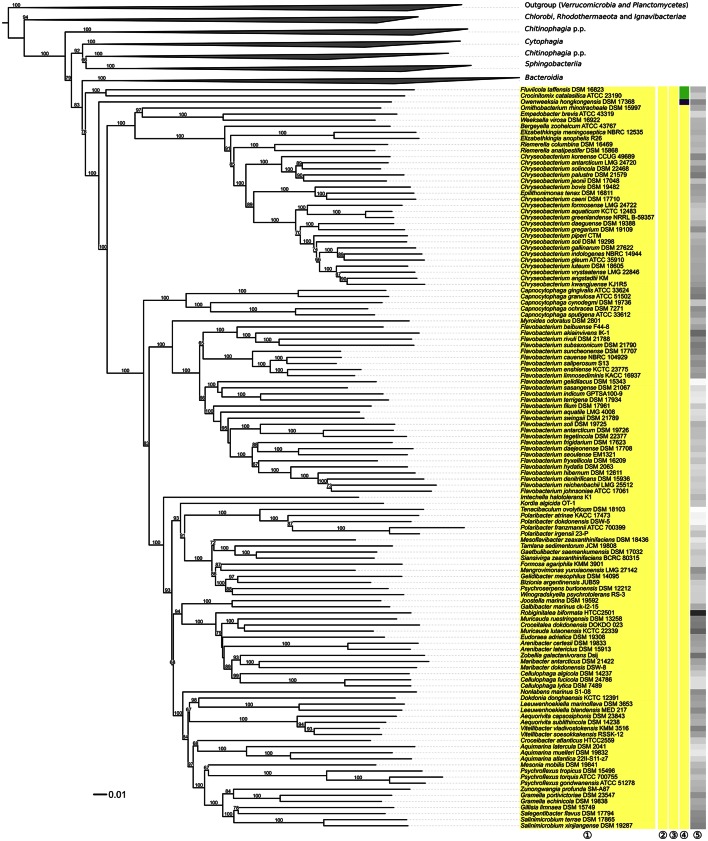
Third part of the phylogenomic tree inferred with GBDP. Tree inferred with FastME from GBDP distances calculated from whole proteomes. The numbers above branches are GBDP pseudo-bootstrap support values from 100 replications. Tip colors indicate the phylum, colors to the right of the ingroup tips indicate, from left to right, class, order and family (see the legend embedded in Figure 2 for details). Gray scale on the very right indicates the exact G+C content as calculated from the genome sequences. The non-Flavobacteriia parts of the tree, which have been collapsed here, are shown in Figures 2, 3.